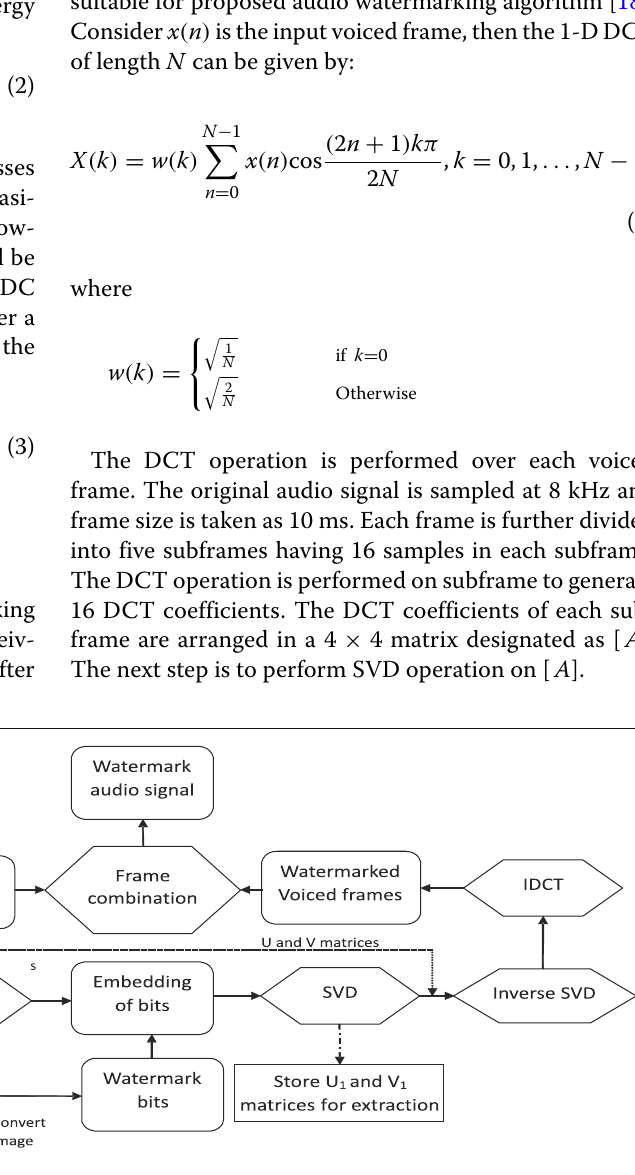
Fig. 3 Embedding procedure: The block diagram show the major steps involved in embedding watermark image in original audio signal using proposed